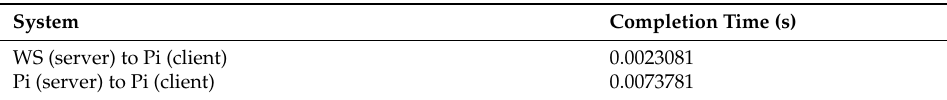
Table 9. Ethernet